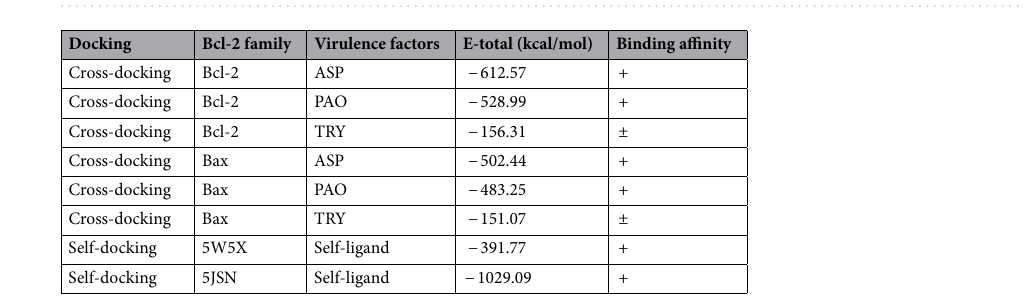
Figure5. I (The docking results between apoptotic-regulator proteins (yellow/right) and virulence factors of C. albicans (left). The van der Waals surface of each atom in the protein structure is demonstrated. ( a ) Successful docking between ASP and Bcl-2. ( b ) Protein–protein interaction \ successfully occurred between ASP and Bax. ( c ) Successful docking between PAO and Bcl-2. ( d ) Protein–protein interaction occurred between PAO and Bax. ( e ) The docking between TRY and Bcl-2 with low affinity. ( f ) Protein–protein interaction occurred between TRY and Bax with low affinity. Bax; simulated Bax of Gallus gallus . Bcl-2; simulated Bcl-2 of Gallus gallus . ASP aspartic proteinases: virulence factor of C. albicans. PAO polyamine oxidase: virulence factor of C. albicans. TRY tryptophol: virulence factor of C. albicans. II (Validation stage through self-dockings between apoptotic-regulator proteins (left) and their original ligands (green/right) ( a ) 5JSN; Crystallographic structure of human Bcl-2 in complex with specific inhibitor. ( b ) 5W5X; crystallographic structure of human Bax in complex with specific activator. ( c and d ) Binding orientations predicted by the self-dockings are in agreement with the binding orientations confirmed by experiment.) III (Cross docking between C. albicans virulence factors (left) and apoptotic-regulator proteins (green/right). Similar residues located in the binding sites of 5JSN and 5W5X facing toward their ligands are illustrated (white/blue) ( a ) 5JSN; Crystallographic structure of human Bcl-2 protein in complex with specific inhibitor. ( b ) 5W5X; crystallographic structure of human Bax protein in complex with activator. ( c ) Successful cross-docking between ASP and 5JSN. ( d ) Successful cross-docking between ASP and 5W5X. ( e ) Successful cross-docking between PAO and 5JSN. ( f ) Successful cross-docking between PAO and 5W5X. ( g ) Cross-docking between TRY and 5JSN with low affinity. ( h ) Cross- docking between TRY and 5JSN with low affinity. ASP; aspartic proteinases: virulence factor of C. albicans. PAO polyamine oxidase: virulence factor of C. albicans. TRY tryptophol: virulence factor of C. albicans. Figure 5.I, II and III were created using the HEX 8.0.0 software http://hex.loria .fr/dist/index .php).